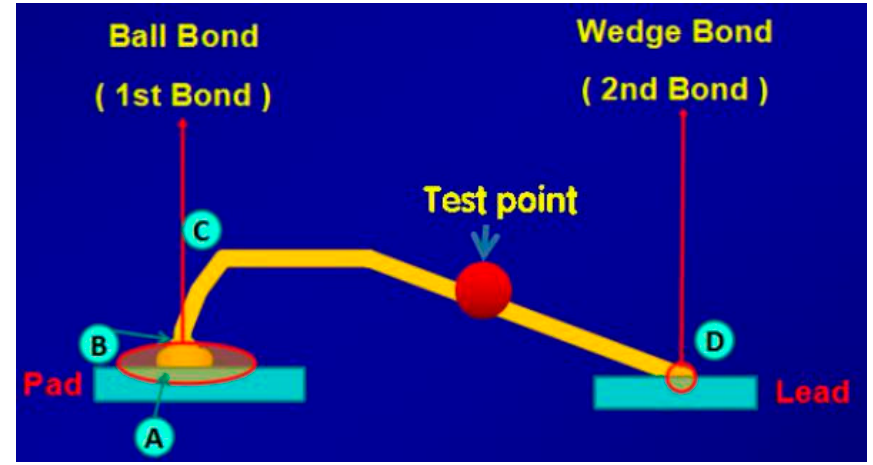
Figure 3. Schematic diagram of tensile test and breaking position.